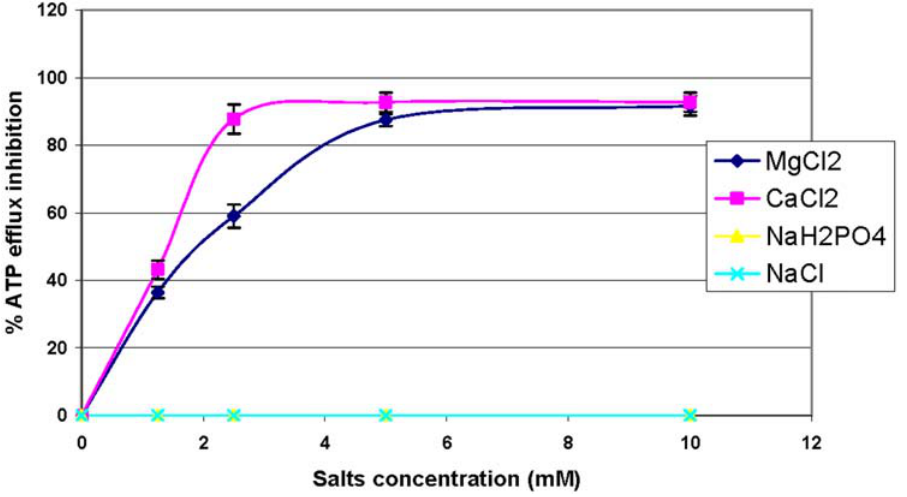
Figure 6. ATP efflux inhibition in E.coli in the presence of squalamine (5 m g/mL) and various mono and divalent salt solutions. doi:10.1371/journal.pone.0002765.g006 PLoS ONE |